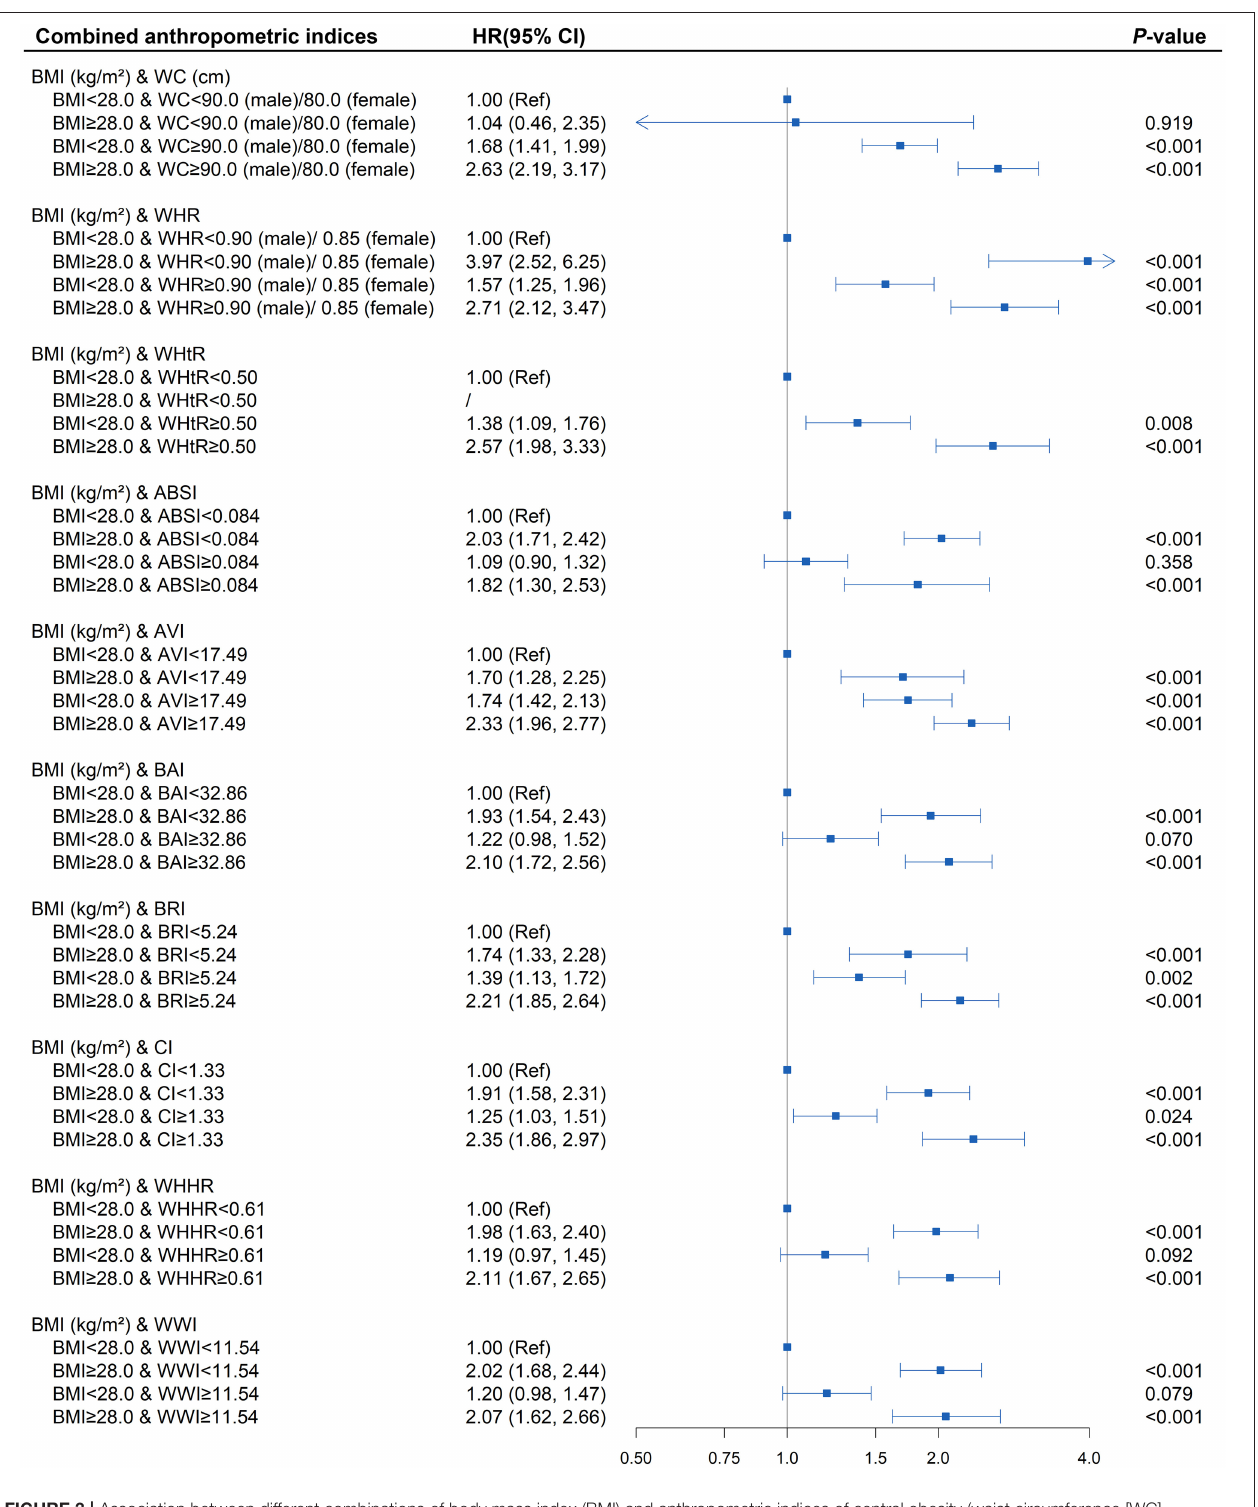
Frontiers in Cardiovascular Medicine |